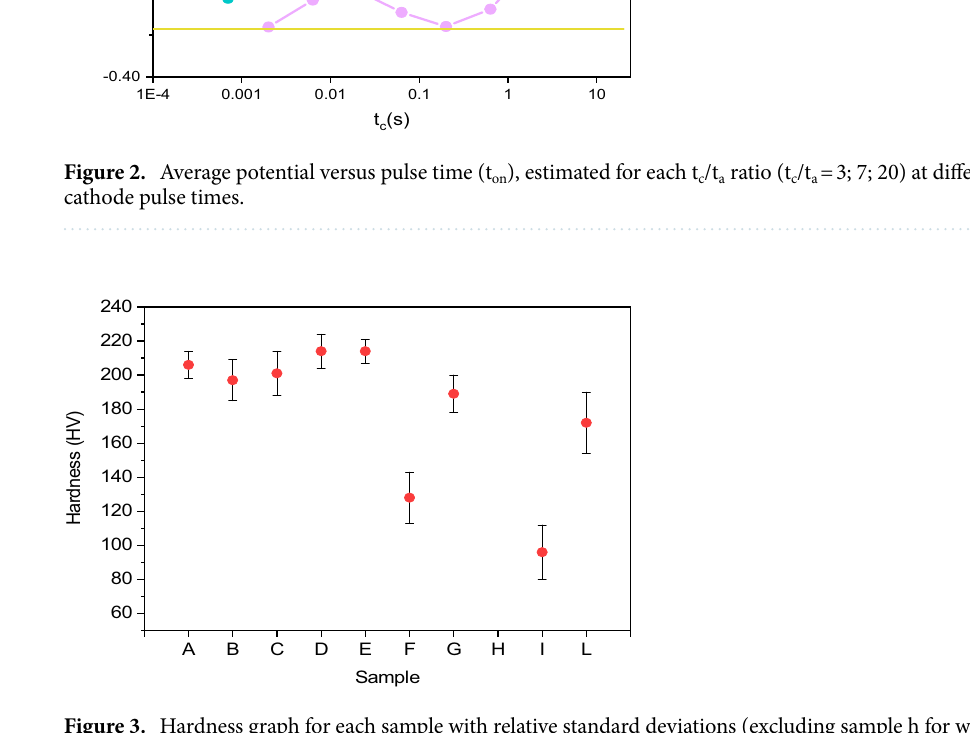
Figure 3. Hardness graph for each sample with relative standard deviations (excluding sample h for which measurement was not